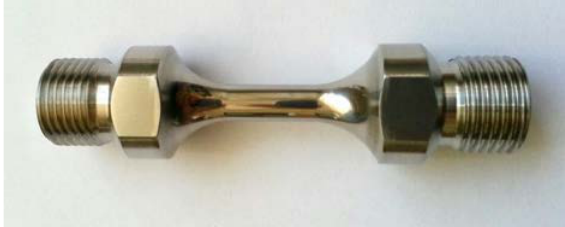
Figure 16. Plain cylindrical test specimen.